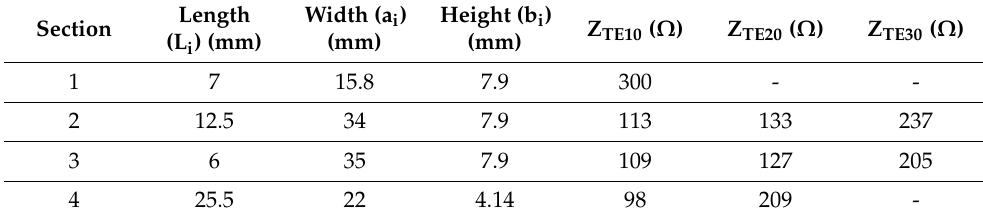
Figure 2. Electric field inside the mode converter at 15 GHz. Table 1. Converter dimensions after optimization at 15 GHz.